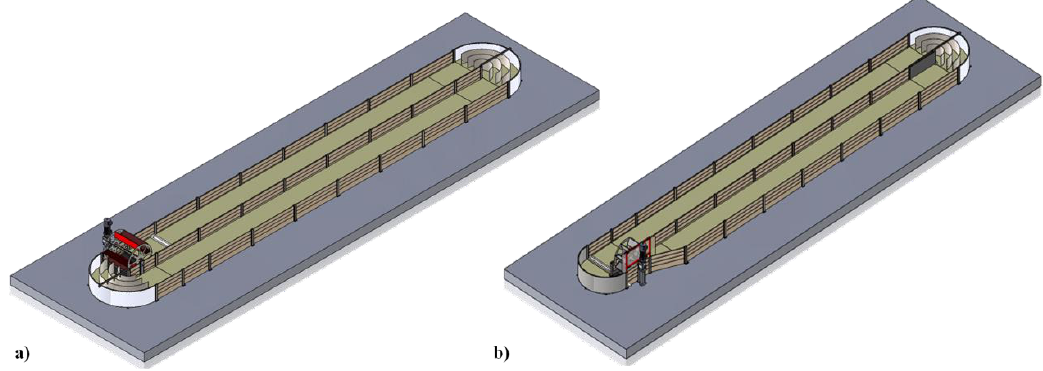
Figure 1. 3D prototype models of the two built raceways. ( a ) Standard raceway model with three baffles, an eight-bladed paddlewheel and 87 cm width; ( b ) Modified raceway model, with three deflectors, an eight blades paddlewheel and 47 cm width.